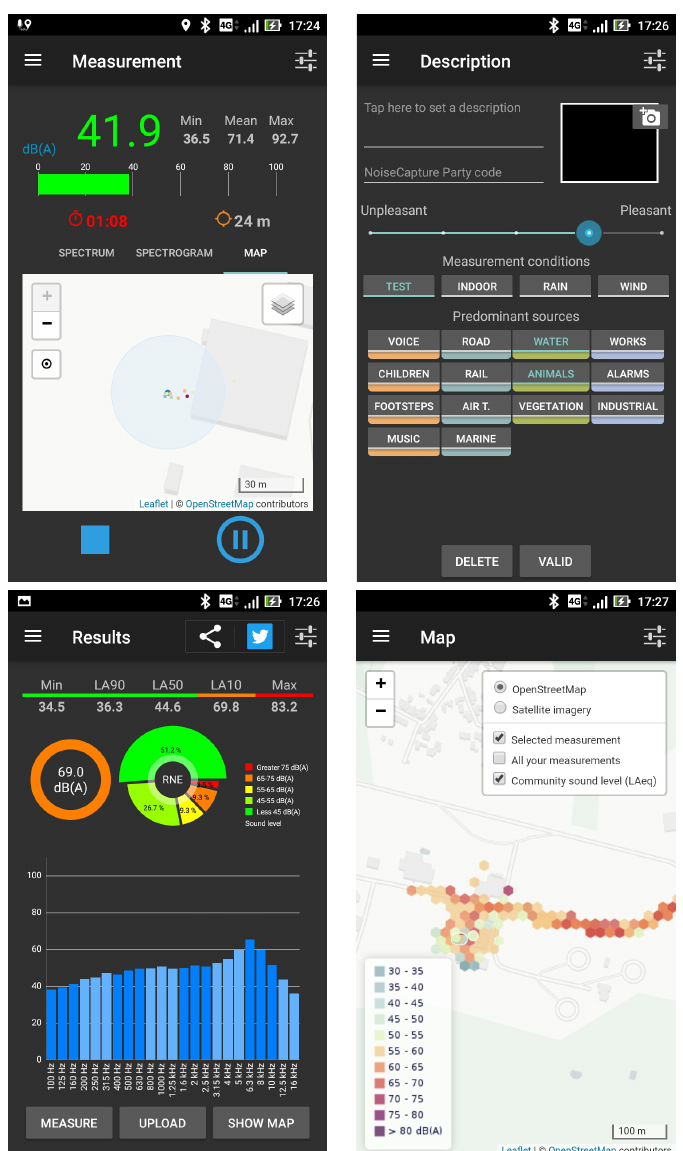
Figure 1. NoiseCapture Android application main screens. From top / down and left / right : Mea- surement, Description, Results,